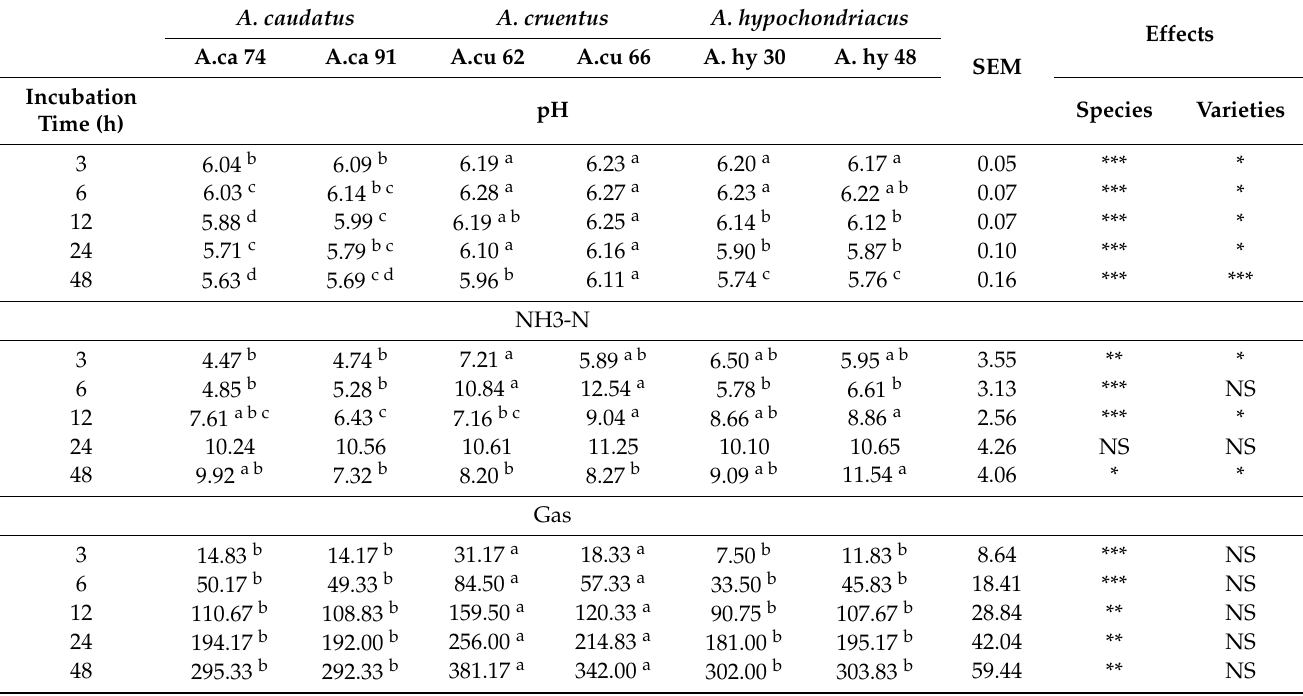
Table 2. The pH, ammonia-N concentration (mg/100 mL), and total gas production (mL) of amaranth forages incubated in vitro in rumen